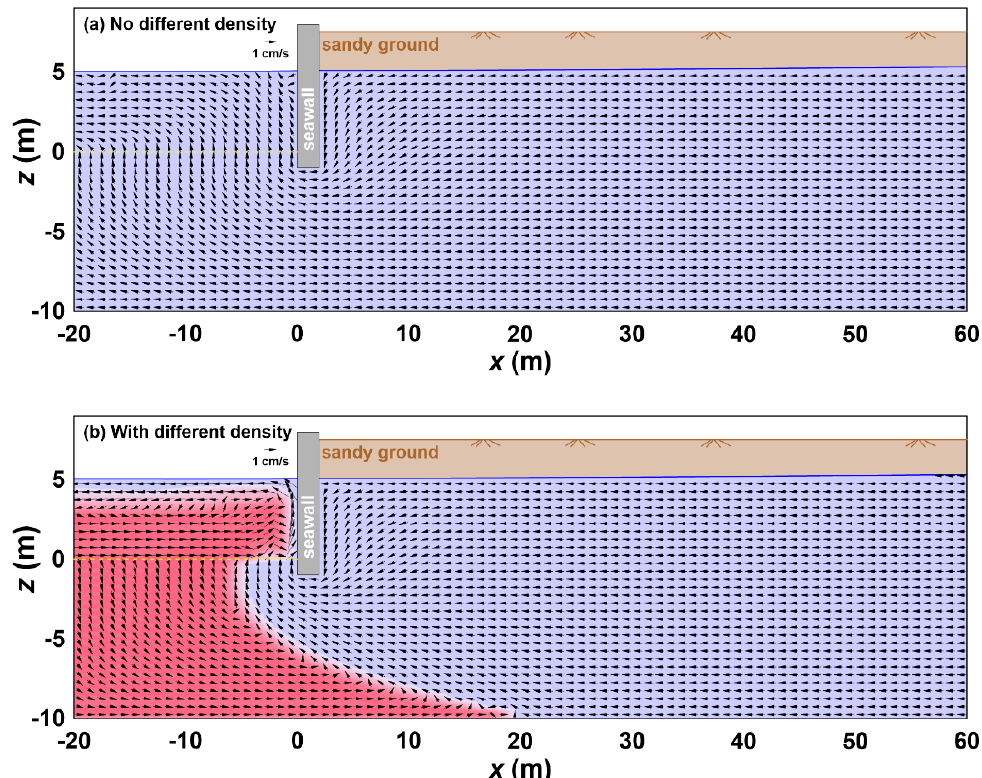
Figure 10. Comparison of groundwater flow in a coastal aquifer with a seawall for ( a ) no difference in density and ( b ) different densities between seawater and groundwater. Δ h = 0.75 m. The red section indicates seawater and the blue indicates freshwater.